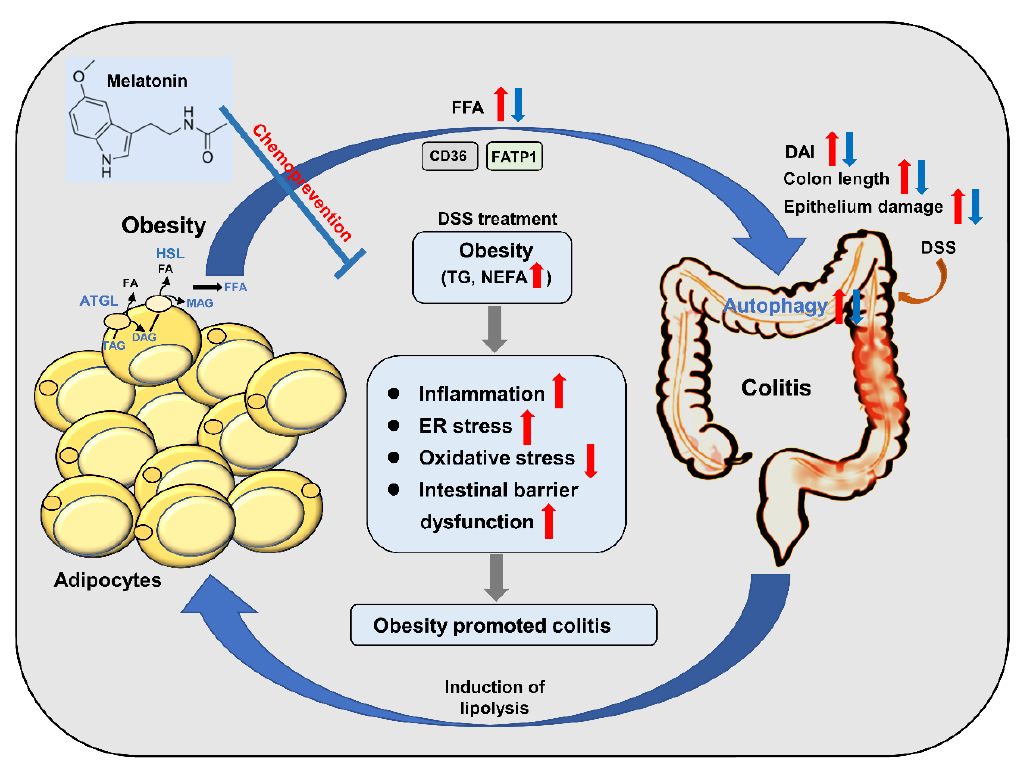
Figure 8. Schematic model depicting melatonin prevents colitis in obese individuals. HFD-promoted obesity accelerated DSS-induced colitis, while melatonin intervention improved colitis in mice. Melatonin significantly alleviated inflamma- tion by increasing anti-inflammatory cytokine release and reducing the level of proinflammatory cytokines induced by HFD + DSS in mice. Furthermore, melatonin expressed antioxidant activities, resulting in improved colitis in HFD + DSS- treated mice. Moreover, melatonin reverses intestinal barrier integrity in DSS-treated obese mice. In addition, melatonin could reduce the ability of inflammatory cells to utilize fatty acids and decrease the growth-promoting effect of lipids by inhibiting autophagy. Taken together, the results indicate that the inhibitory effect of melatonin on autophagy weakens the lipid-mediated prosurvival advantage, which suggests that melatonin-targeted autophagy may provide a unique opportunity to prevent obesity-associated colitis. The red arrows represent the role of the HFD + DSS group. The blue arrow represents the action of the melatonin group.